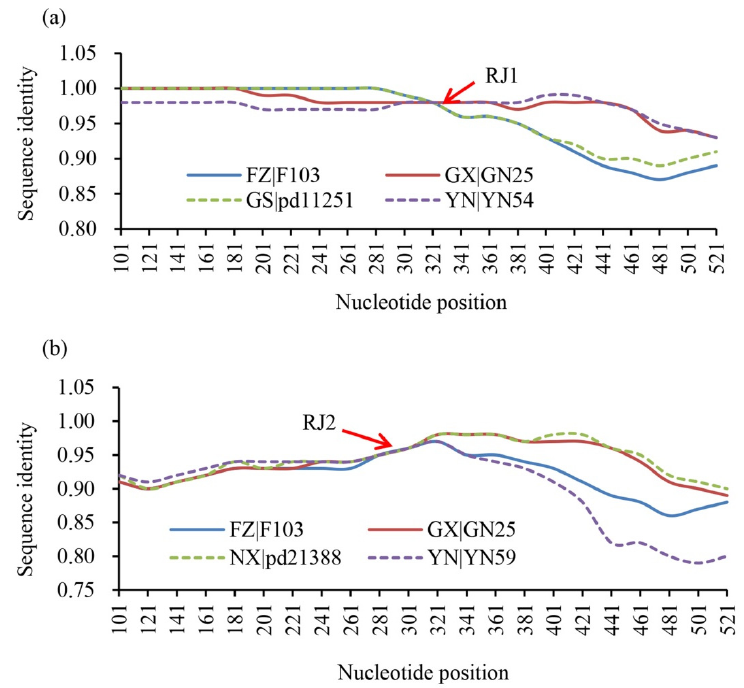
Figure 5. Potential recombination sites and their candidate parental sequences evaluated by Simplot: ( a ) intragenic recombinant generated by F103 and GN25 or pd11252 and YN54; ( b ) intragenic recombinant generated by F103 and GN25 or pd21388 and YN59; RJ1 and RJ2 indicated the putative recombination break points.